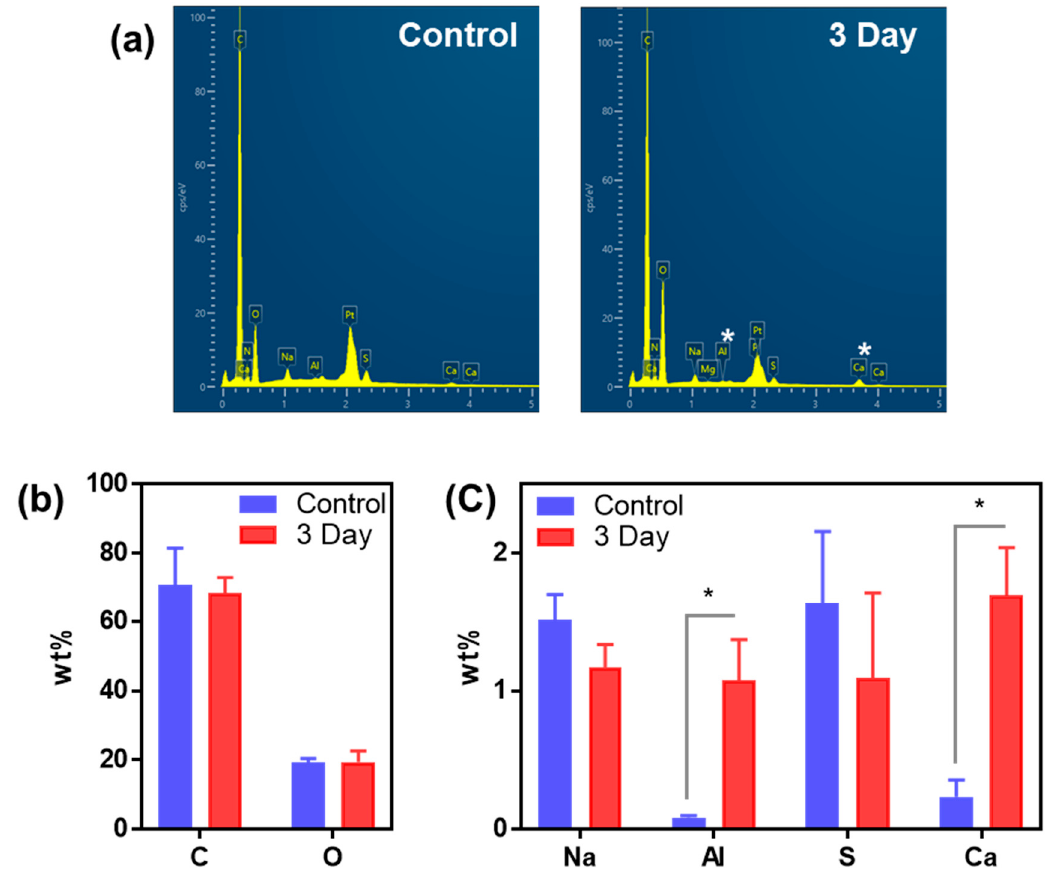
Figure 4. Elemental analysis in KDP20 three-day exposed olfactory organs using energy dispersive X-ray spectroscopy (EDS). ( a ) EDS spectrum of control and KDP20 three-day exposure groups; ( b ) Carbon (C) and oxygen (O); ( c ) sodium (Na), aluminum (Al), sulfur (S), and calcium (Ca) contents of control and KDP20 three-day exposure groups. Values are reported as mean ± SEM of three distinct olfactory organ samples. Statistical analysis by t -test, * p < 0.05.